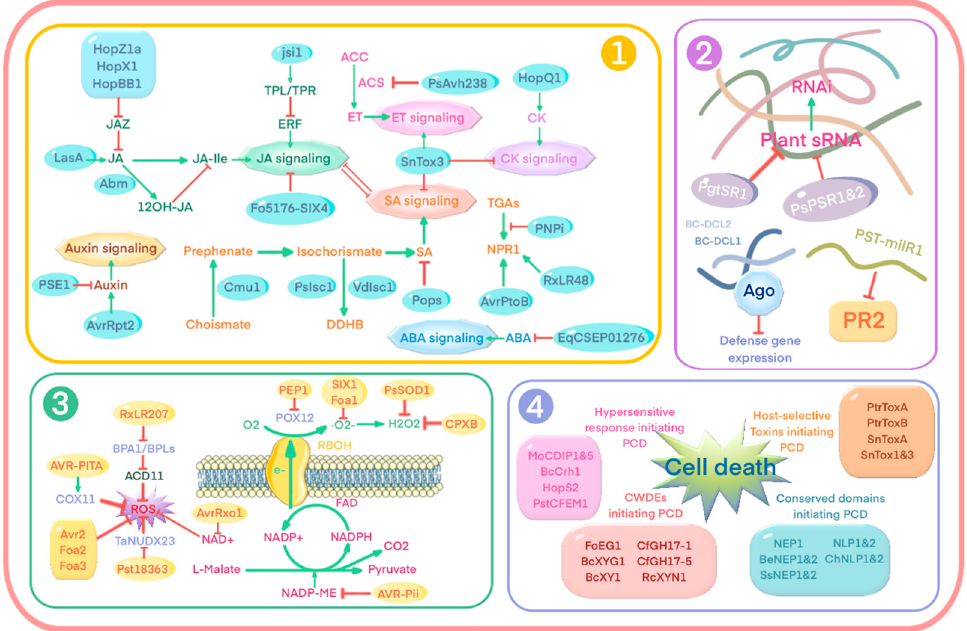
Figure 5. Effectors manipulate downstream immune responses in host plants. Effectors mainly manipulate plant downstream immune responses by interfering with plant hormone transduction, disrupting plant RNA silencing, regulating ROS generation, and manipulating plant cell death. The effector chorismate mutase Cmu1 of Ustilago maydis , the oomycete pathogen Phytophthora sojae and the fungus Verticillium dahliae effectors PsIsc1 and VdIsc1, POPs in Ralstonia solanecearum , P. striiformis f.sp. effector PNPi, P. syringae effector AvrPtoB, HopZ1a, HopBB1, HopX1, HopAF1, AvrRpt2, HopQ1, Phytophthora capsicum effector RxLR48, F. oxysporum Fo5176-SIX4, rice blast effector ABM, LASA of L. medterranea, Phytophthora sojae RxLR effector PsAvh238, Phytophthora effector PSE1 and EqCSEP01276 of Erysiphe quercicola SnTox3, interfere with the transduction of different hormone signals in plants. The wheat stem rust Puccinia graminis f. sp. tritici effector protein PgtSR1, PsPSR1 and PsPSR2 in Phytophthora sojae , Botrytis cinerea BC-DCL1 and BC-DCL2 and PST-milR1 are gene silencing mechanisms. The maize smut effector PEP1, the biotrophic pathogen Puccinia striiformis PsSOD1 and avirulent proteins AVR-PII, AVR-PITA in M. oryzae , inhibit ROS accumulation. The M. oryzae effector enhances COX activity by interacting with mitochondrial OsCOX11; OsCOX11 is a key regulator of mitochondrial ROS metabolism in rice. RxLR207 in Phytophthora capsici can promote the degradation of BPA1, BPL1, BPL2, and BPL4, and destabilize ACD11 in a 26S proteasome-dependent manner to promote ROS accumulation and PCD activation. F. oxysporum apoplasts (SIX1 and Foa1) and cytoplasmic effectors (Avr2, Foa2 and Foa3) promote host colonization by inhibiting flg22-induced or chitin-induced ROS. There are four main types of effectors that cause cell death, namely effectors that trigger HR responses, host-selective toxins, cell wall-degrading enzyme effectors, and effectors with conserved necrosis-inducing